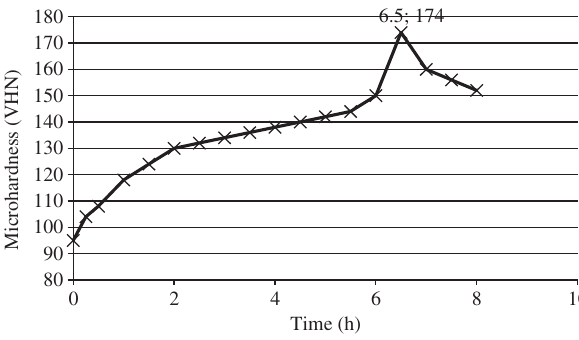
Figure 8: Results of microhardness (VHN) versus time for the wear test specimen subjected to precipitation hardening at 190 ° C after directional